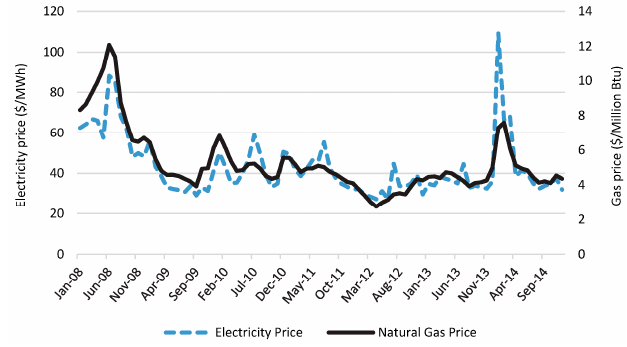
Figure 9. Monthly-based PJM average price of electricity in RTM and the average cost of natural gas for electricity generation in the U.S. The average price of electricity was calculated from the 7395 nodes and the cost of natural gas was based on the data provided in [14].